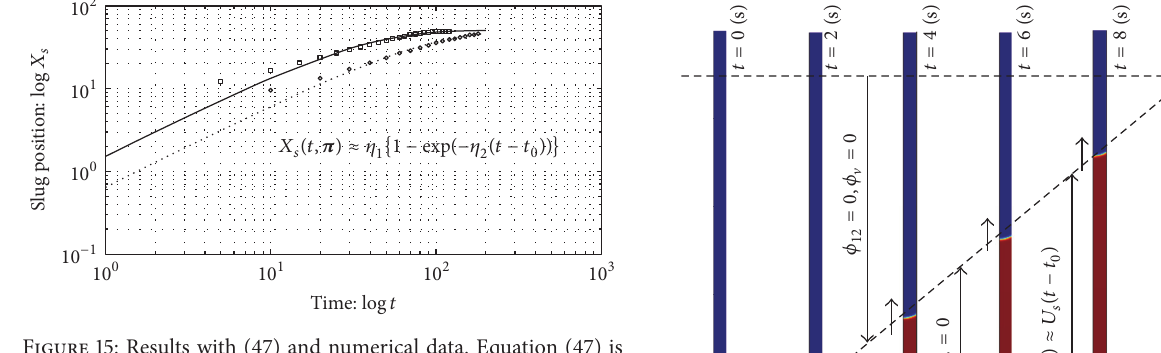
Figure 15: Results with (47) and numerical data. Equation (47) is described in solid line for 𝑙 𝑠 = 30 [mm] and in dotted line for 𝑙 𝑠 = 60 [mm]. Likewise, numerical data is described with circles for 𝑙 𝑠 = 30 [mm] and with squares for 𝑙 𝑠 = 60 [mm].